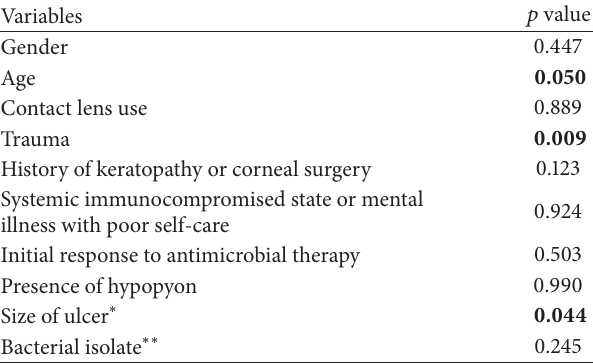
Table 3: Univariate logistic regression of risk factors, presenting features and isolates with the clinical outcome. Age, traumatic etiology, and ulcer size > 3mm predicted a poor clinical